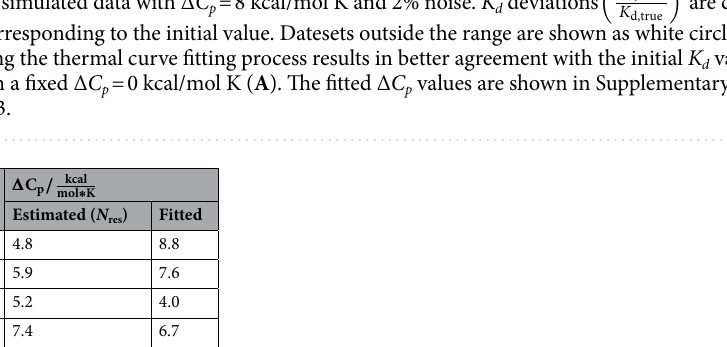
In Table 1, we compared the estimated (cid:31) C p values for the different systems with the fitted values. The fitted value were in each case closer to the estimated value than 0 kcal/mol K. Due to the lack of experimental (cid:31) C p